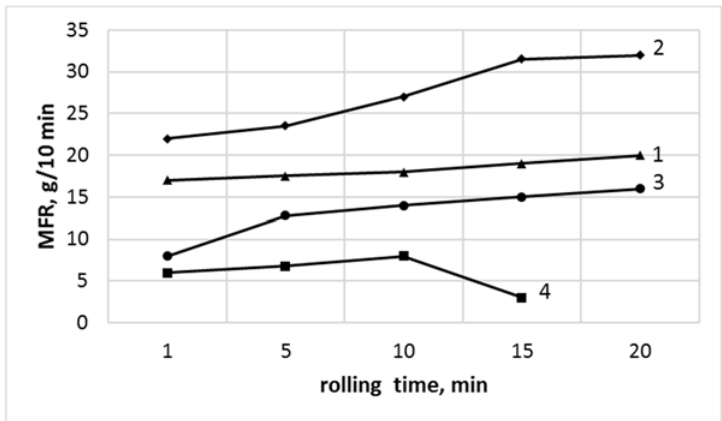
Figure 2. The MFR of PVC and nanocomposites with SiO 2 as a function of rolling time: (1) PVC R /SiO 2 ; (2) PVC R ; (3) PVC C /SiO 2 , and (4) PVC C